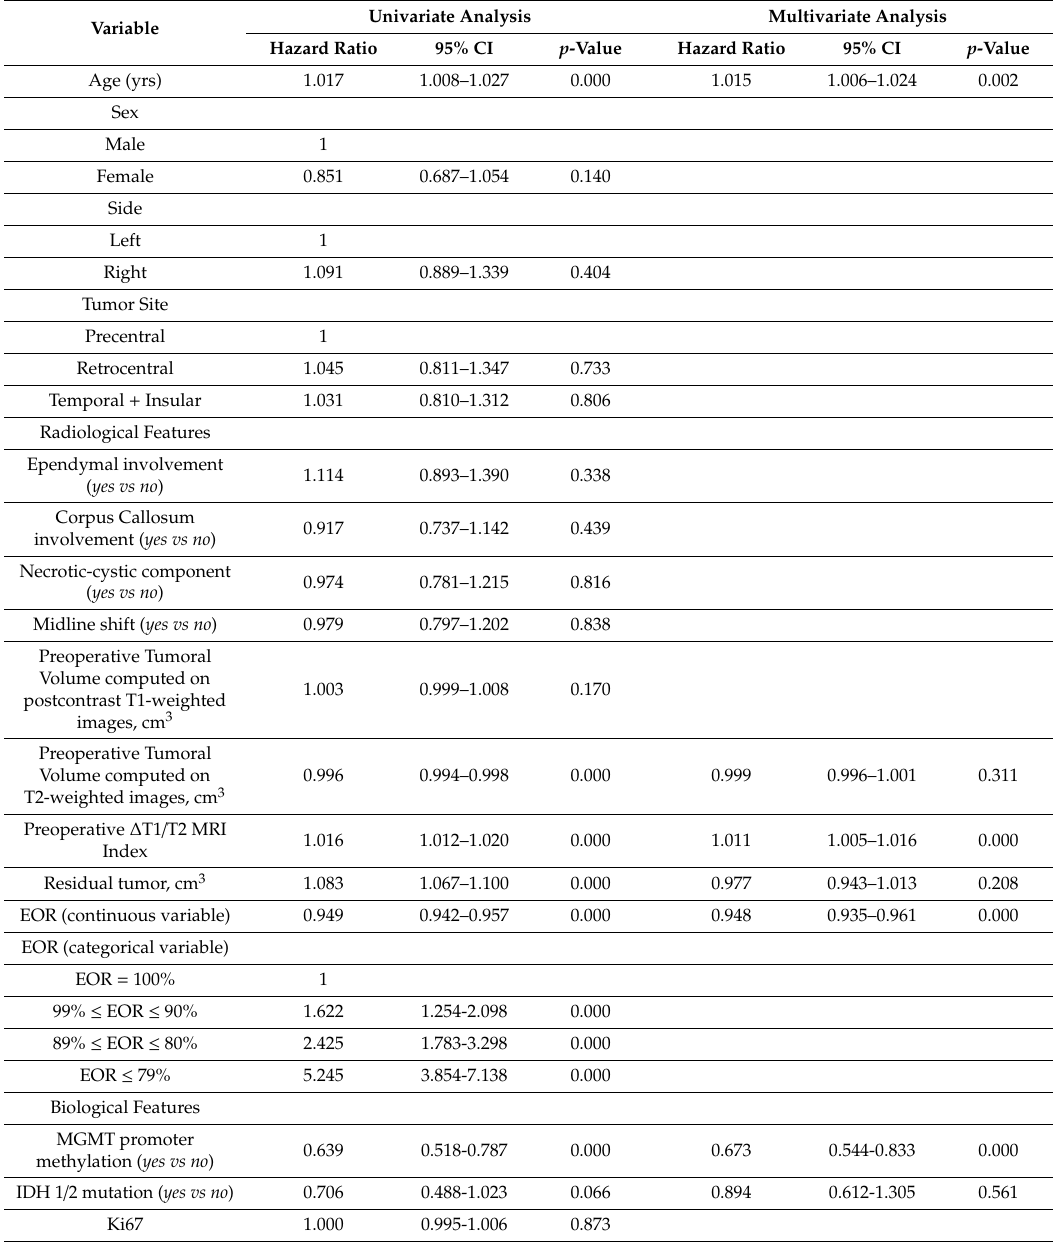
Table showing the influence of di ff erent factors on the PFS rates as per univariate survival analysis and multivariate analysis on the entire GBM patients cohort. ( p -value < 0.05 at Log-rank test). Boldfacing values represent statistical significant results ( p < 0.05). CI = confidence interval; p -value = level of marginal significance; MRI = magnetic resonance image; preoperative ∆ T1 / T2 MRI Index = ratio between pre-operative tumoral volume on postcontrast T1-weighted and T2 weighted images; EOR = extent of resection; CWs = Carmustine Wafers; RT = radiotherapy; CT = chemoteraphy; MGMT = O 6 -methylguanine-DNA methyl-transferase; IDH = isocitrate dehydrogenase; OS = overall